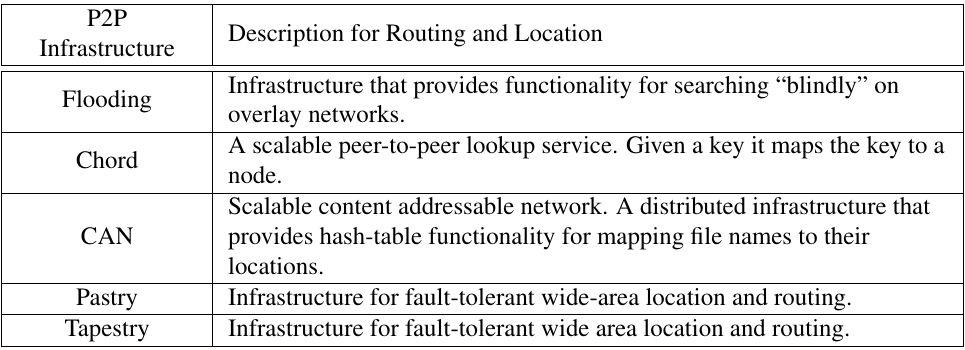
Table 2. Summary of infrastructure for routing and resource discovery location